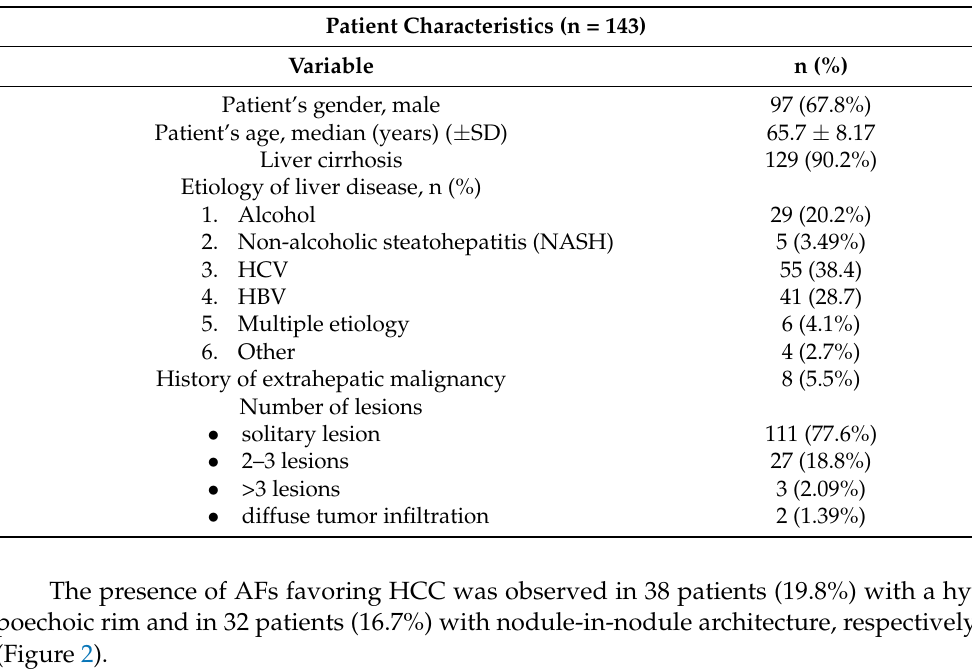
Table 1. Patient characteristics.